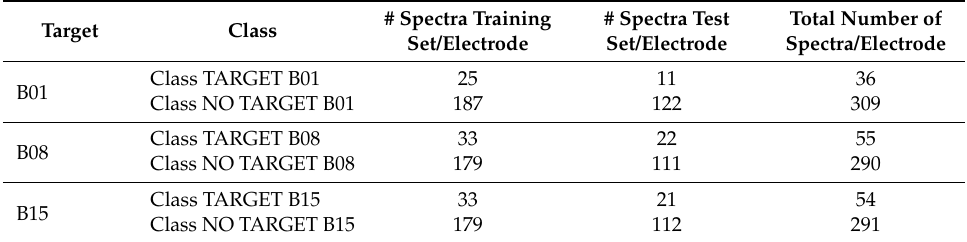
Table 6. Composition of the training set and test set used to compute and validate the classification models of the EC sensor.